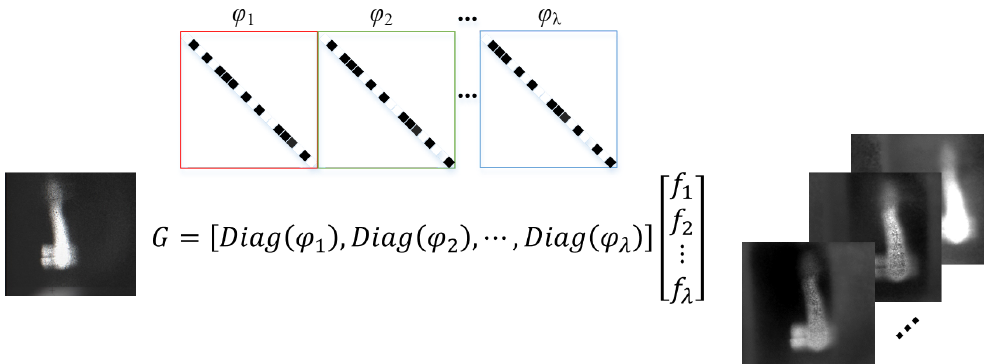
Figure 3. Sensing model of the proposed MWIR-SCSI. The left side shows the measurement (coded image), the top side shows the coded mask, and the right side shows the spectral